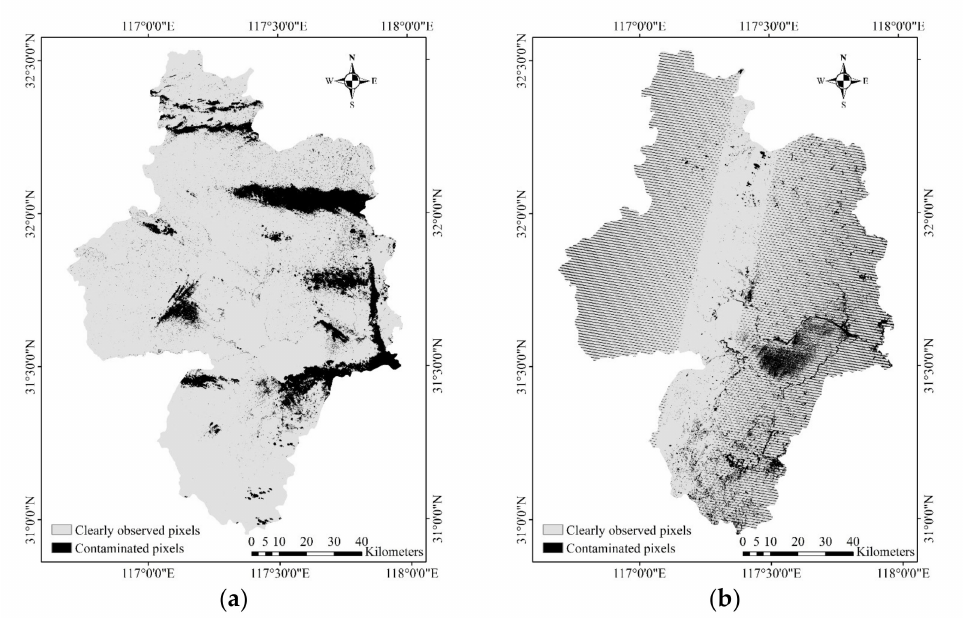
Figure 7. Two examples of clearly observed and contaminated pixels in Hefei City: ( a ) Landsat 5, date 11 May 2003, and ( b ) Landsat 7, date 17 May 2011.